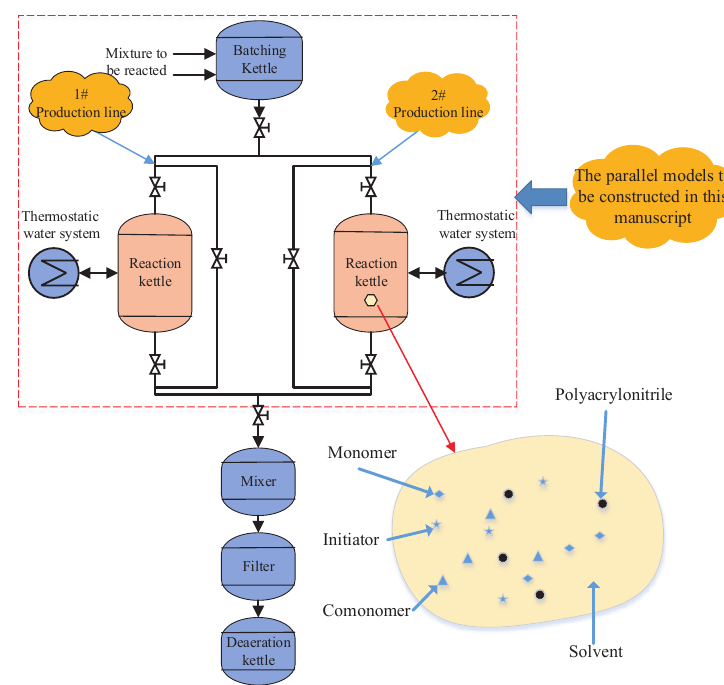
Figure 2. Schematic diagram of polymerization